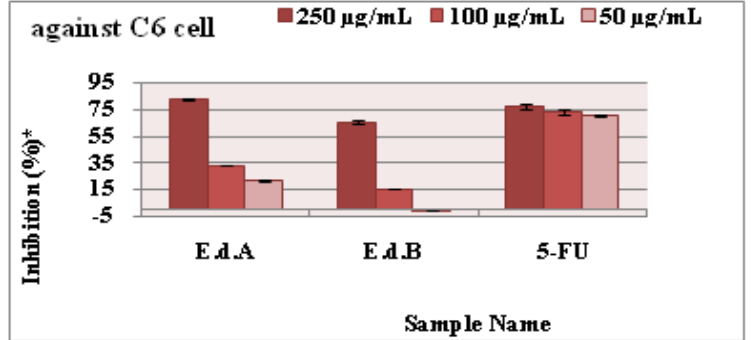
Figure 6. The antiproliferative activities of the two extracts against C6 cells. Each substance was tested twice in triplicates against cell lines. Data show average of two individual experiments ( p < 0.01).